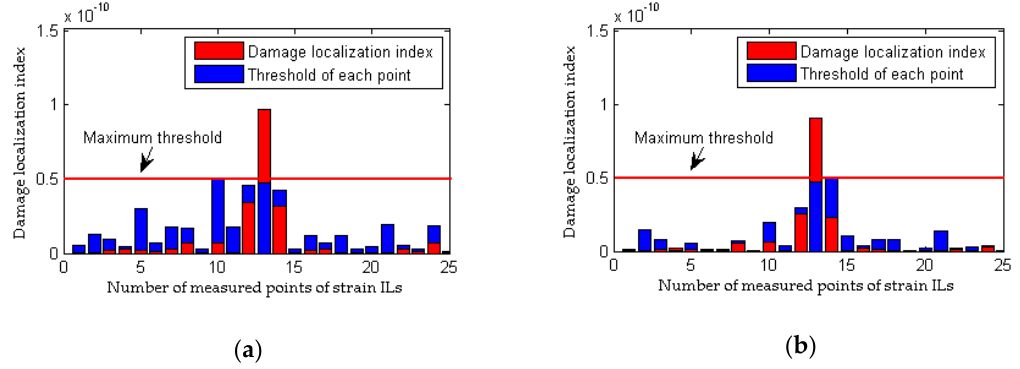
Figure 20. Results of the proposed method for the model bridge: ( a ) results of the #1 beam for experimental case 2; ( b ) results of the #2 beam for experimental case 2.